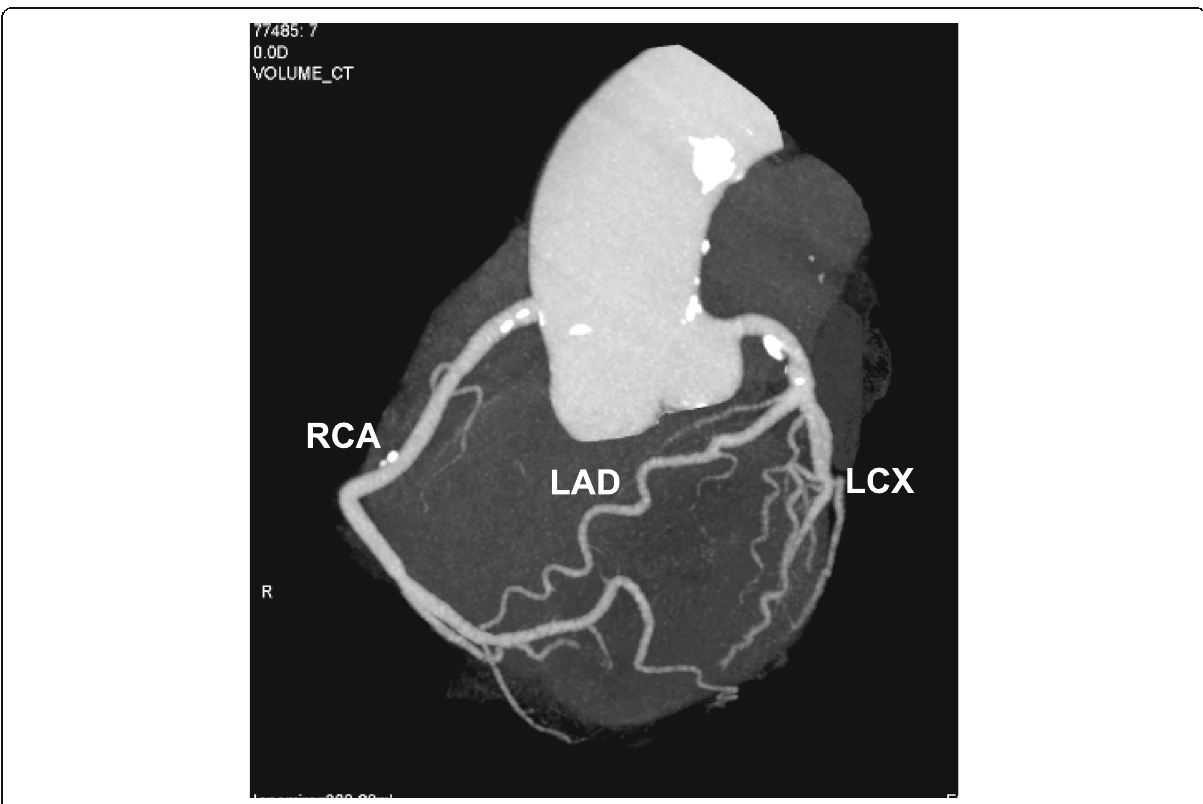
Fig. 3 Coronary computed tomography (CT) angiography. Coronary CT angiography revealed no significant stenosis of coronary arteries although dispersed small spotty calcifications were noted. LCX, left circumflex artery; LAD, left anterior descending artery; RCA, right coronary